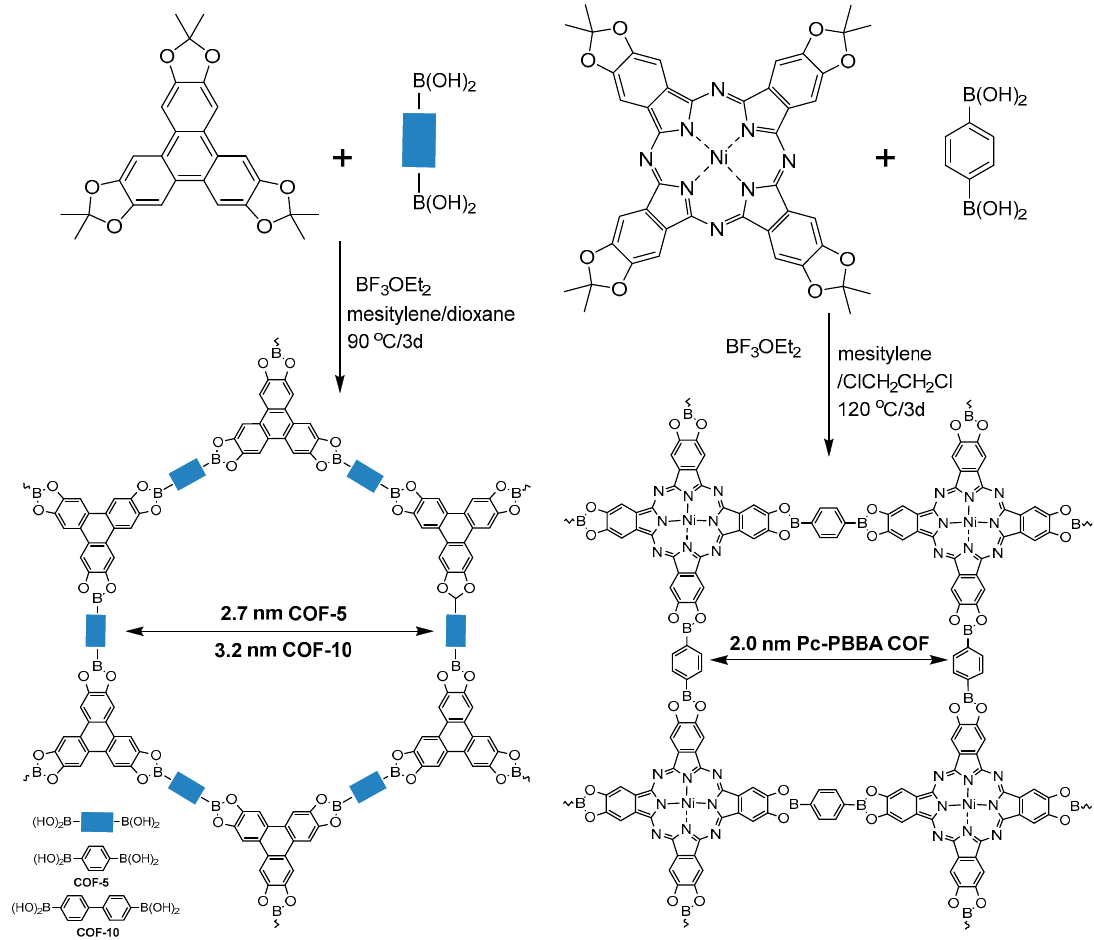
Figure 6. Synthesis of dioxaborole-linked COFs starting from protected catechol-based linkers with boronic acids for improved solubility and anti-oxidation in comparison with pristine catechol linkers.